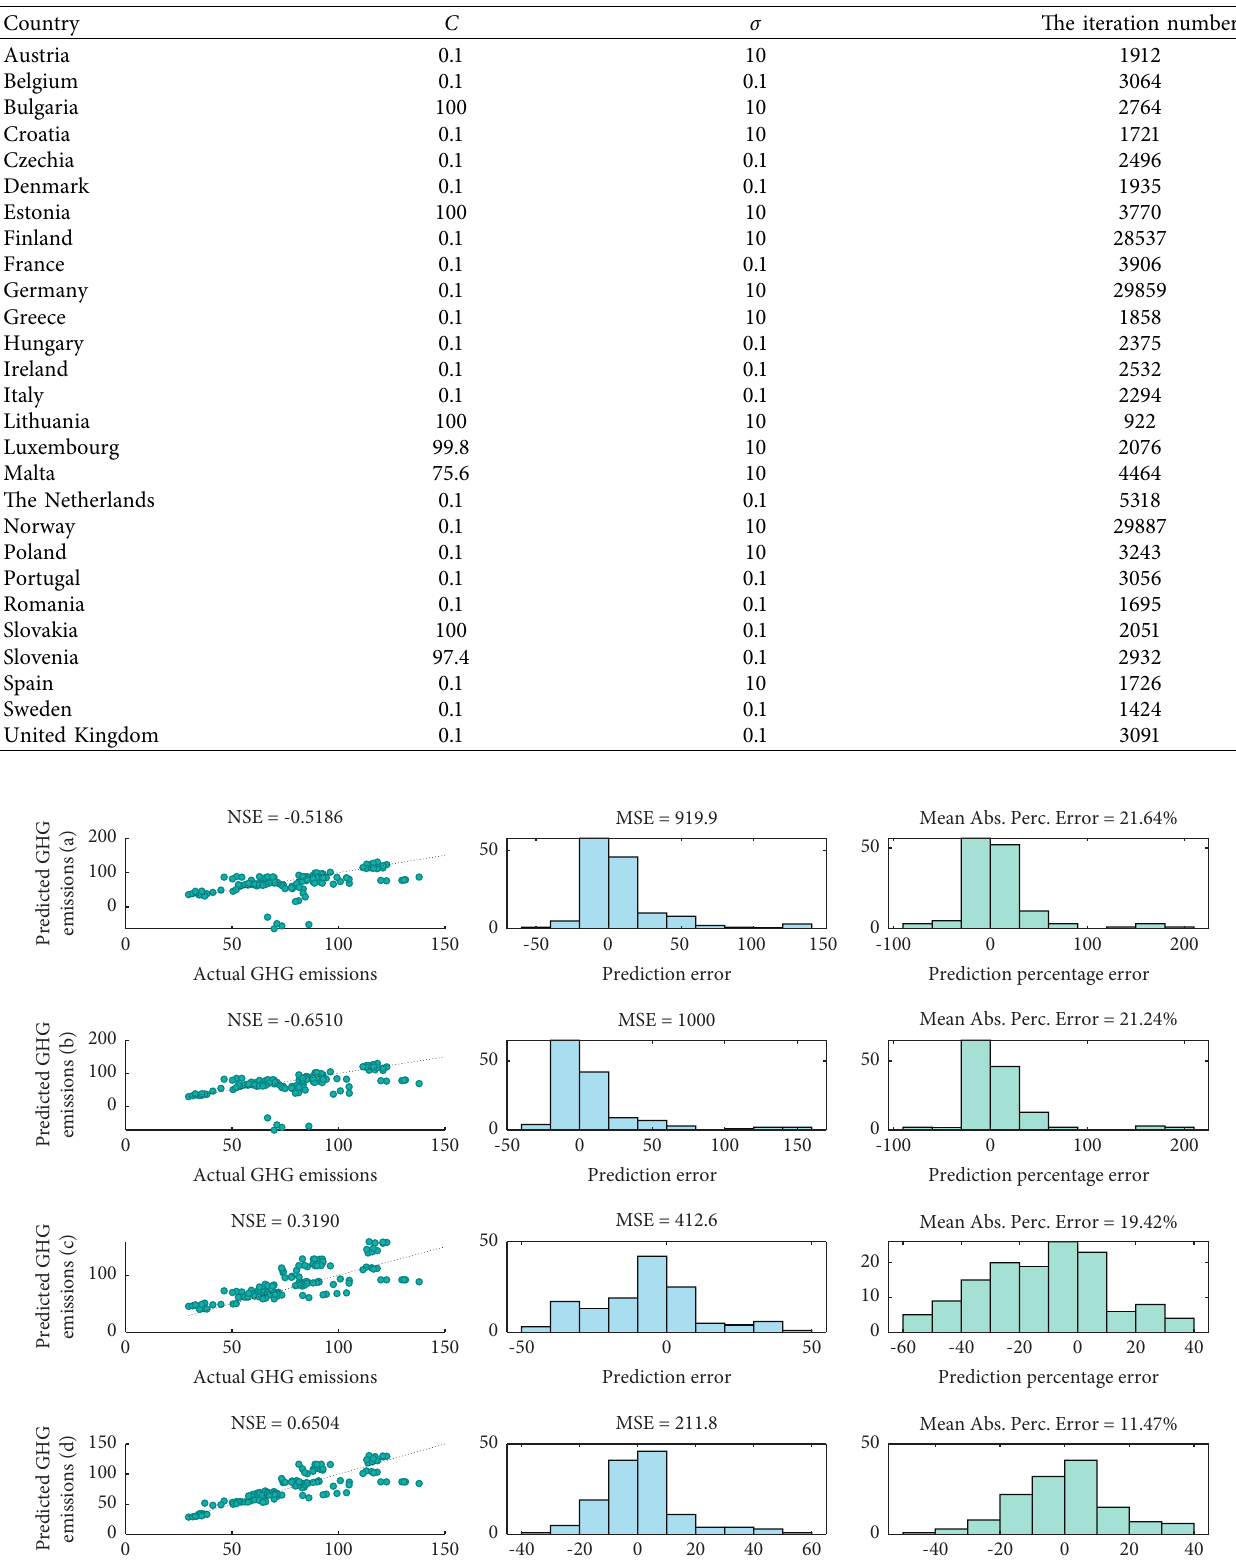
Table 1: Parameter setting and Iteration number for each BKGM (1, N) model.